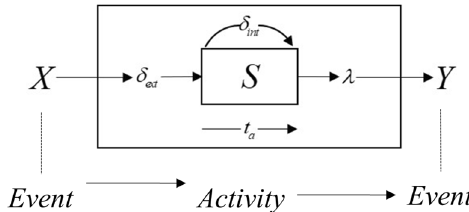
Figure 6. DEVS model.